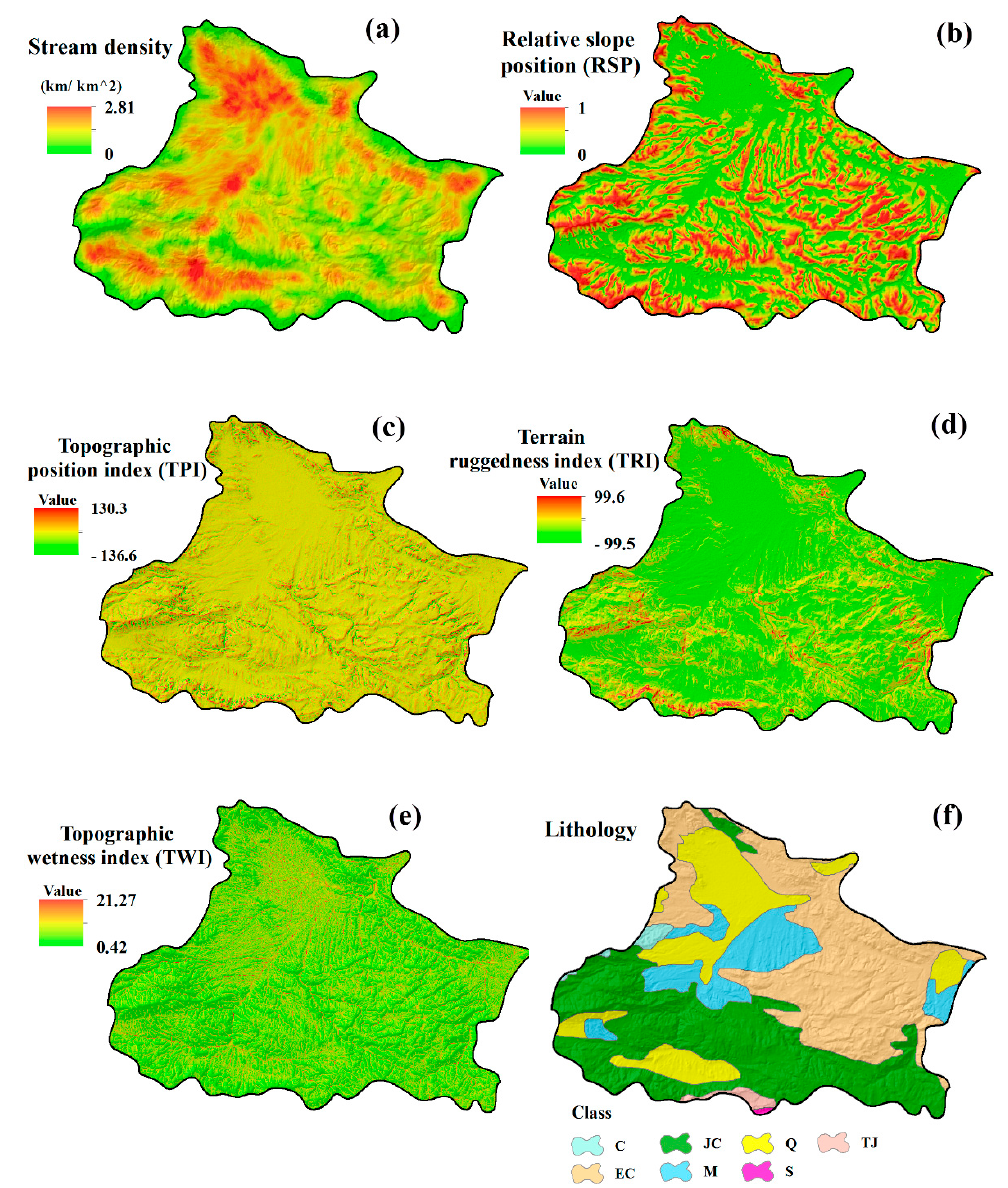
Figure 8. Groundwater-a ff ecting factors in the study area: ( a ) stream density, ( b ) relative slope position, ( c ) topographic position index, ( d ) terrain ruggedness index, ( e ) topographic wetness index, and ( f ) lithology (for a detailed description of lithological classes, see Table